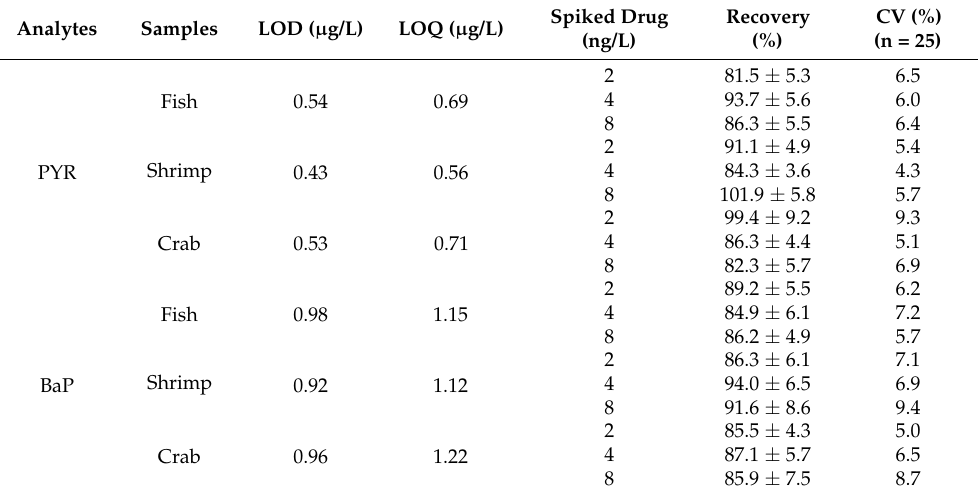
Table 2. The LODs, LOQs, CV and recoveries of PYR and BaP in aquatic